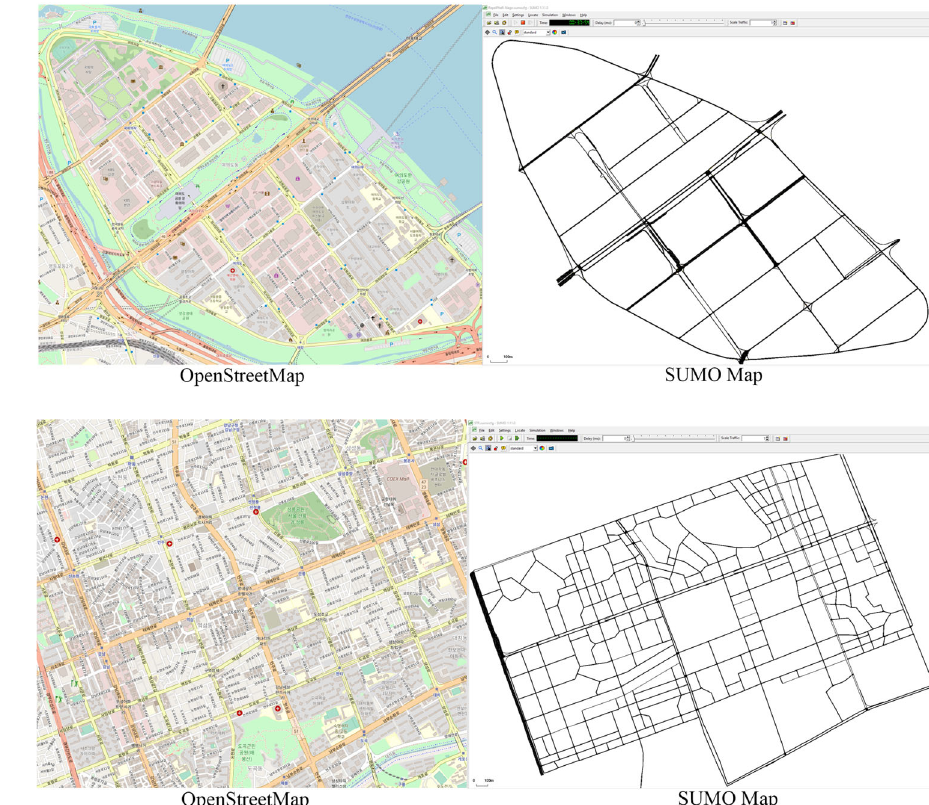
Fig. 4 Gangnam district traffic network scenario (around 12.60 km 2